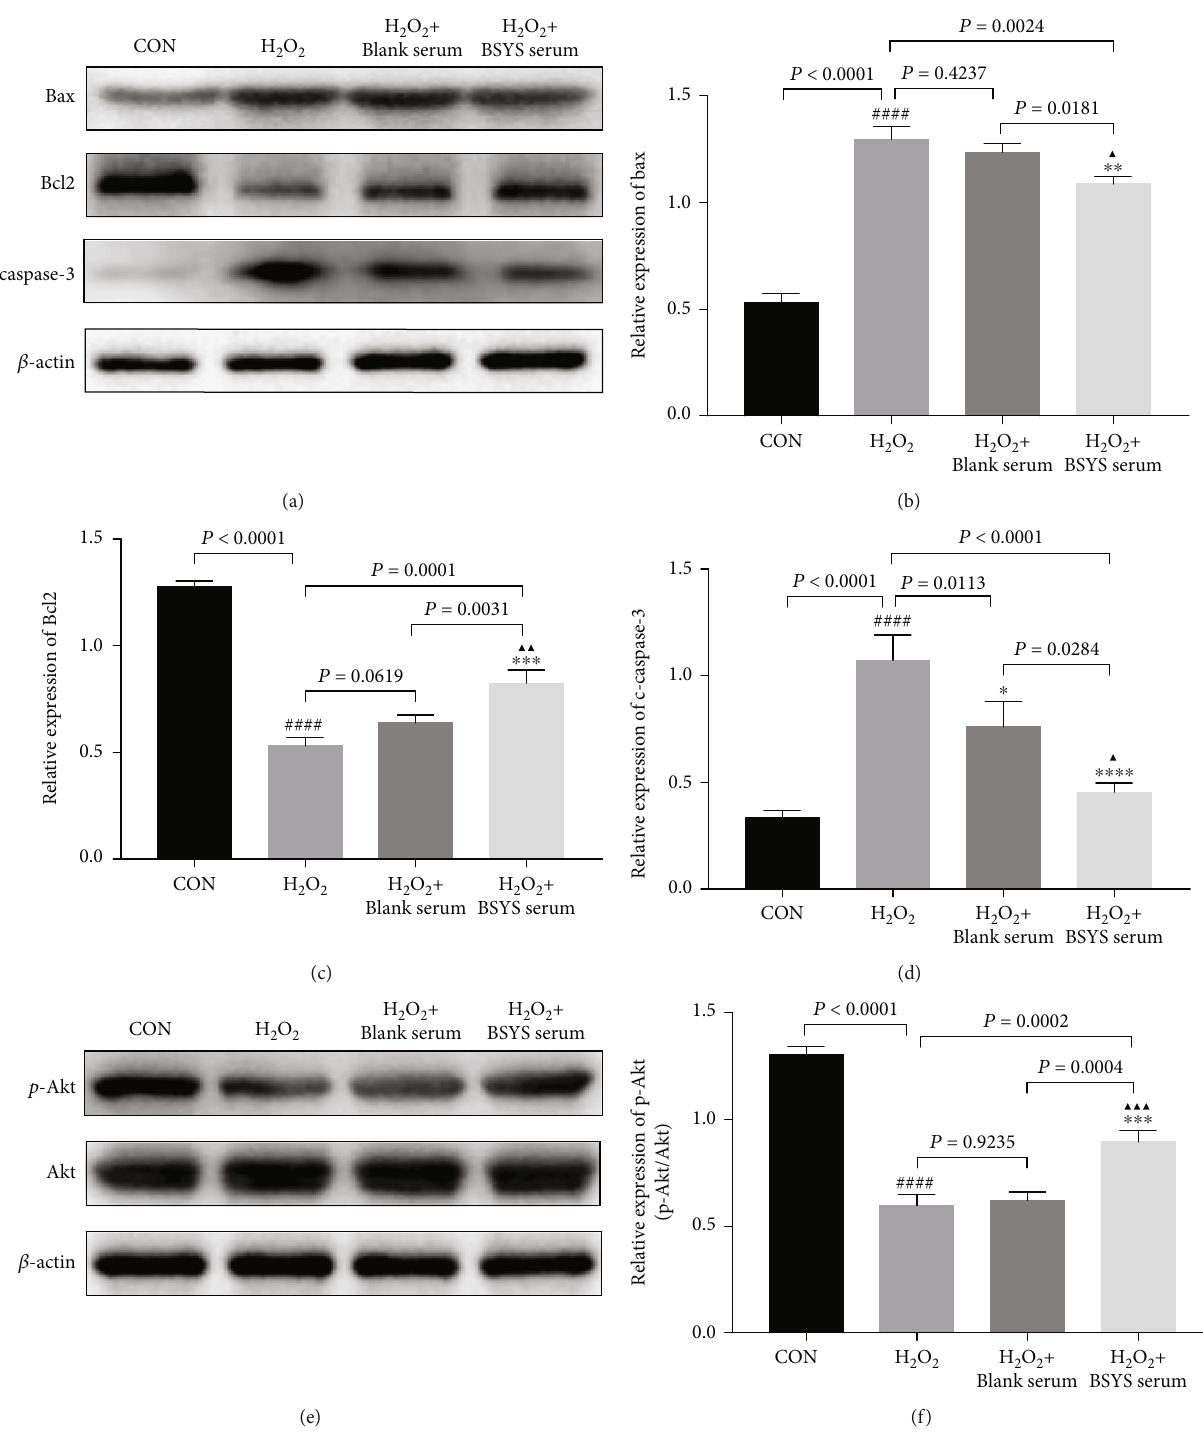
Figure 9: BSYS serum regulates the level of apoptosis-related proteins and the Akt pathway. (a) – (d) Representative blots and statistical graphs of relative protein expression of Bax, Bcl-2, and c-caspase3 in OLN-93 cells. (e, f) Representative western blot images and quantitative data of p-AKT and AKT in OLN-93 cells. Data are presented as means ± SD , compared with the CON group, #### P < 0 : 0001 O group, ∗ P < 0 : 05 , ∗∗ P < 0 : 01 , ∗∗∗ P < 0 : 001 ; and compared with the H ; compared with the H 2 2 ▲▲ P < 0 : 01 , ▲▲▲ P < 0 : 001